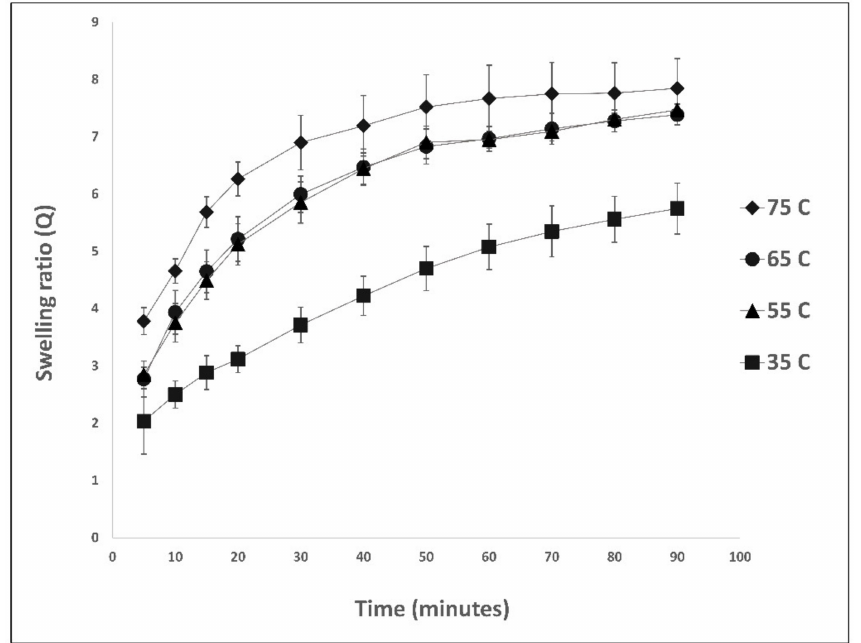
Figure 2. Kinetic swelling study of IONP-acrylamide nanocomposite exposed to different tempera- tures. (N = 3, error bars represent the standard